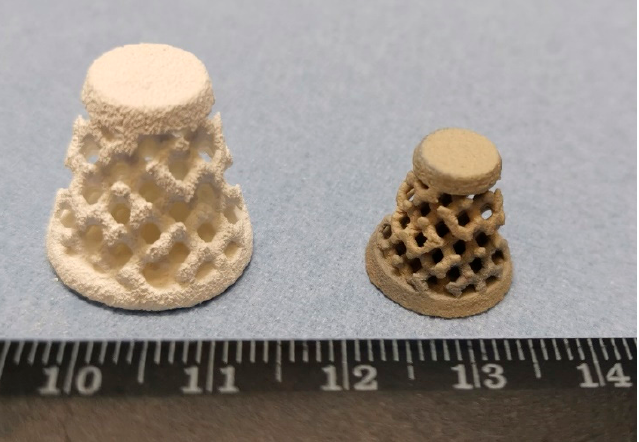
Figure 12. Image of samples with lattice structures printing by BJ from F-BaTiO 3 powder before ( left ) and after sintering ( right ).